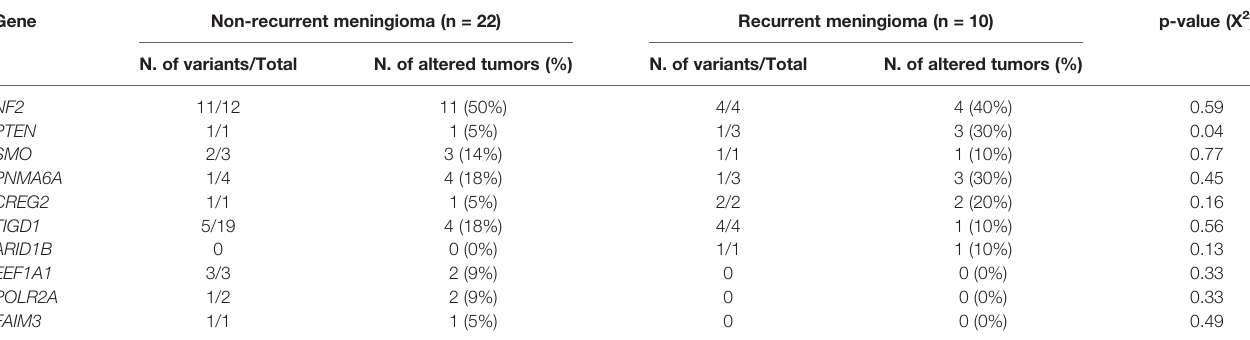
TABLE 3 | Distribution of the non-synonymous genetic variants identi fi ed in non-recurrent vs recurrent WHO grade 1 meningiomas. Gene Non-recurrent meningioma (n = 22) Recurrent meningioma (n =